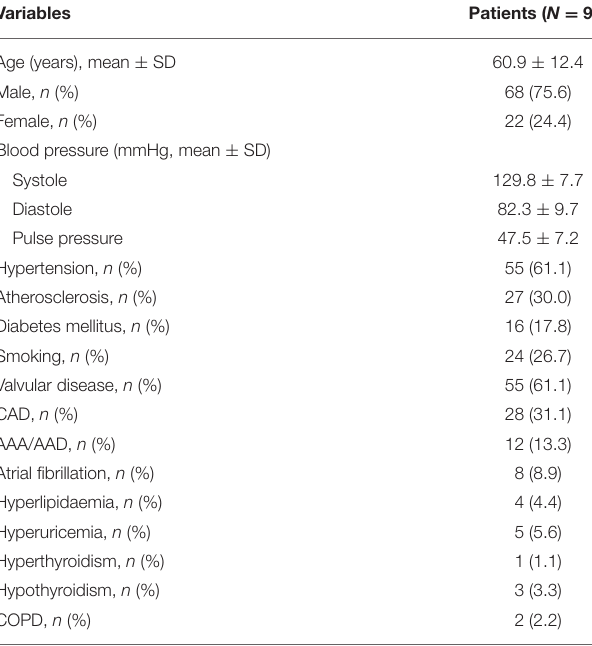
TABLE 1 | Baseline characteristics of the patients.